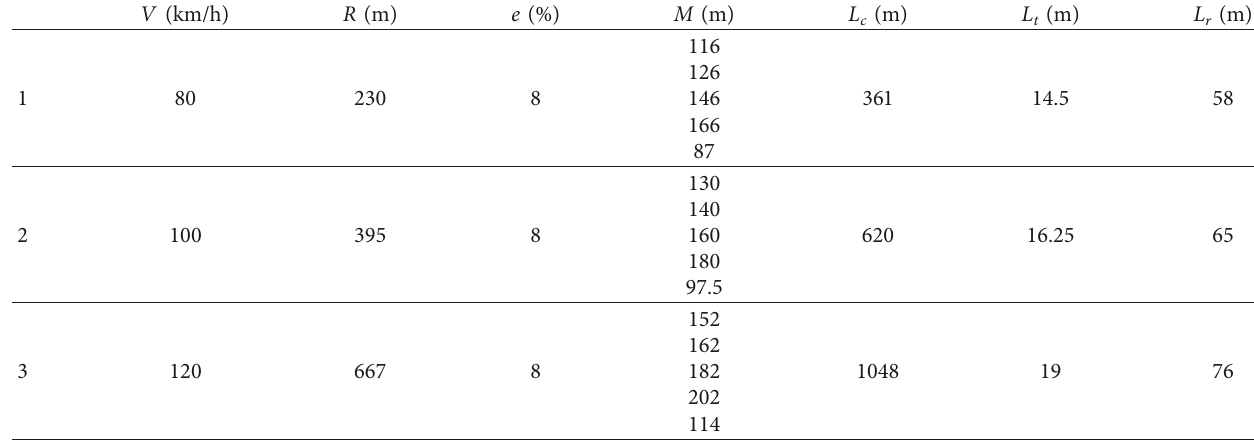
Table 1: Characteristics of reverse horizontal curves simulated in the road